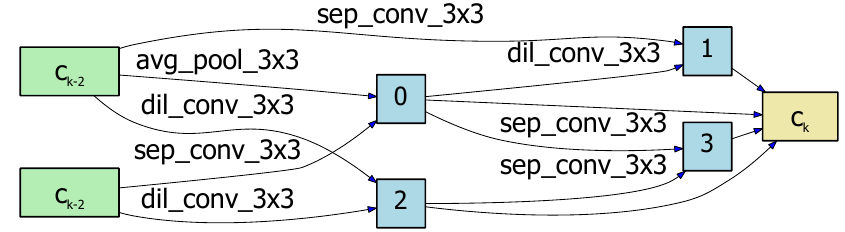
Figure 4. The normal cell searched by NAS-HRIS on WHUBuilding_Dataset.